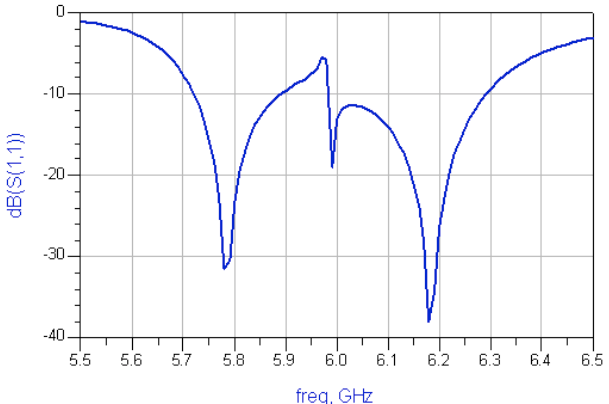
Figure 14: Reflection co-efficient S11 of equivalent circuit The simulation of the reflection co-efficient S11 of equivalent circuit provides the same result of resonant frequency of the proposed patch antenna in Layout with a slight increase of return